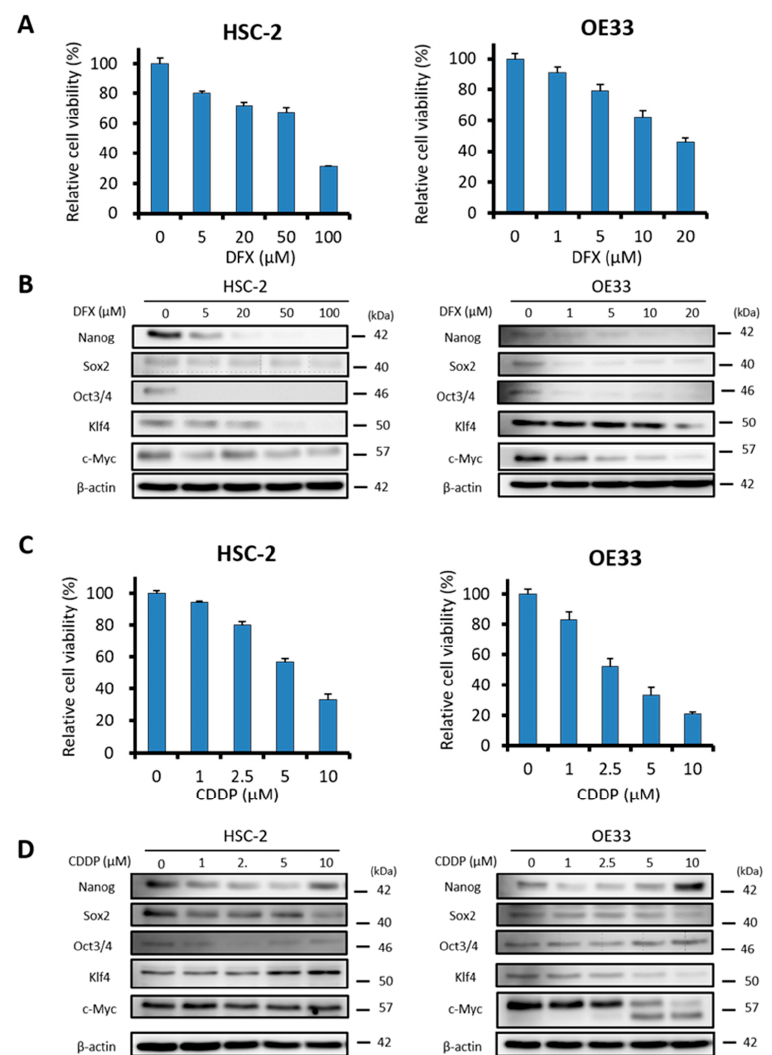
Figure 3. Effect of DFX on proliferation and expression of stemness markers in human cancer cell lines in vitro. ( A ) Cultured HSC-2 cells and OE33 cells were treated with different concentrations of DFX for 48 h, and cell viability was evaluated with the XTT assay. DFX suppressed the proliferation of HSC-2 cells and OE33 cells in a dose-dependent manner. Cell viability in the absence of treatment was set at 100%. ( B ) After culturing HSC-2 cells and OE33 cells with different concentrations of DFX for 48 h, cell lysates were collected, and the total protein was analyzed for expression of the indicated stemness markers with western blot analysis. Expression of stemness markers was suppressed by DFX in a dose-dependent manner. ( C ) Cultured HSC-2 cells and OE33 cells were treated with different concentrations of CDDP for 48 h, and cell viability was evaluated with the XTT assay. CDDP suppressed the proliferation of HSC-2 cells and OE33 cells in a dose-dependent manner. Cell viability in the absence of treatment was set at 100%. ( D ) After culturing HSC-2 cells and OE33 cells with different concentrations of CDDP for 48 h, cell lysates were collected, and the total protein was analyzed for expression of the indicated stemness markers with western blot analysis. Most stemness markers were upregulated or unchanged after treatment with